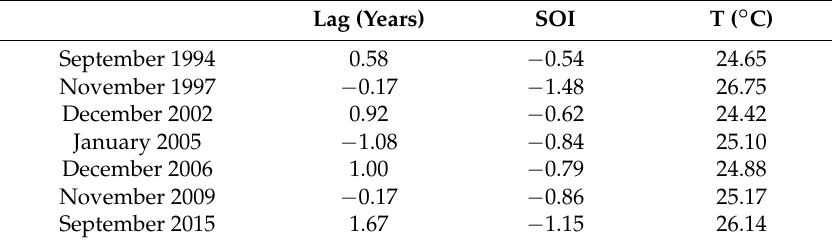
Table 1. The lag (in years) and the sea temperature at 2 ◦ S 180 ◦ W averaged over 125 to 175 m in depth, 7–8 months prior to the minimum SOI of the ENSO events occurring between late 1992 and 2017. The lag is deduced from the date of appearance compared to the central value of 4-year intervals of January 1992 to January 1996, January 1996 to January 2000, etc.